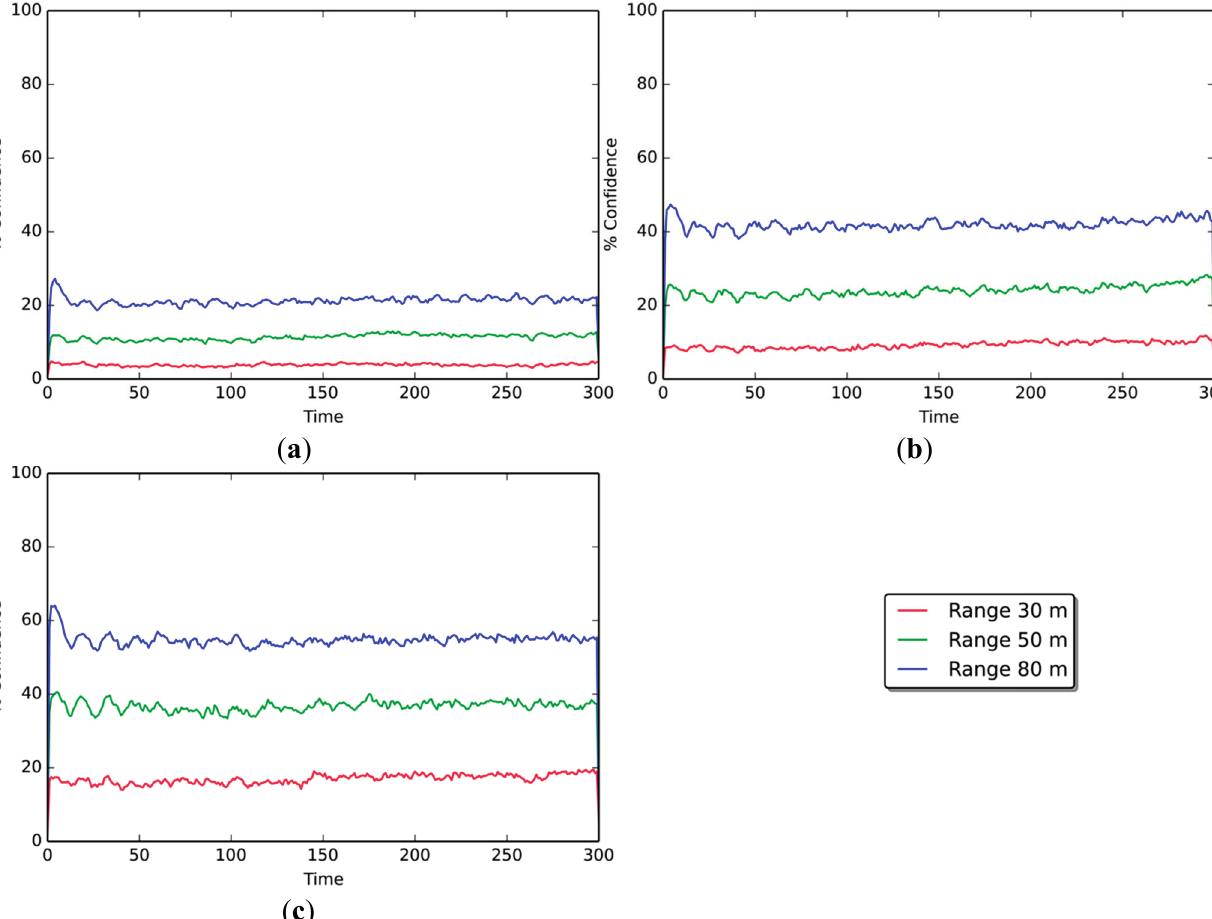
Figure 5. Average confidence of non-beacon nodes per range, in scenarios with ( a ) 10 beacon nodes, ( b ) 25 beacons, and ( c ) 50